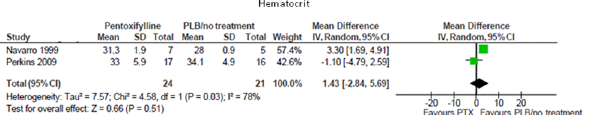
Fig 2. Effects of pentoxifylline vs. placebo/standard treatment on hemoglobin levels.